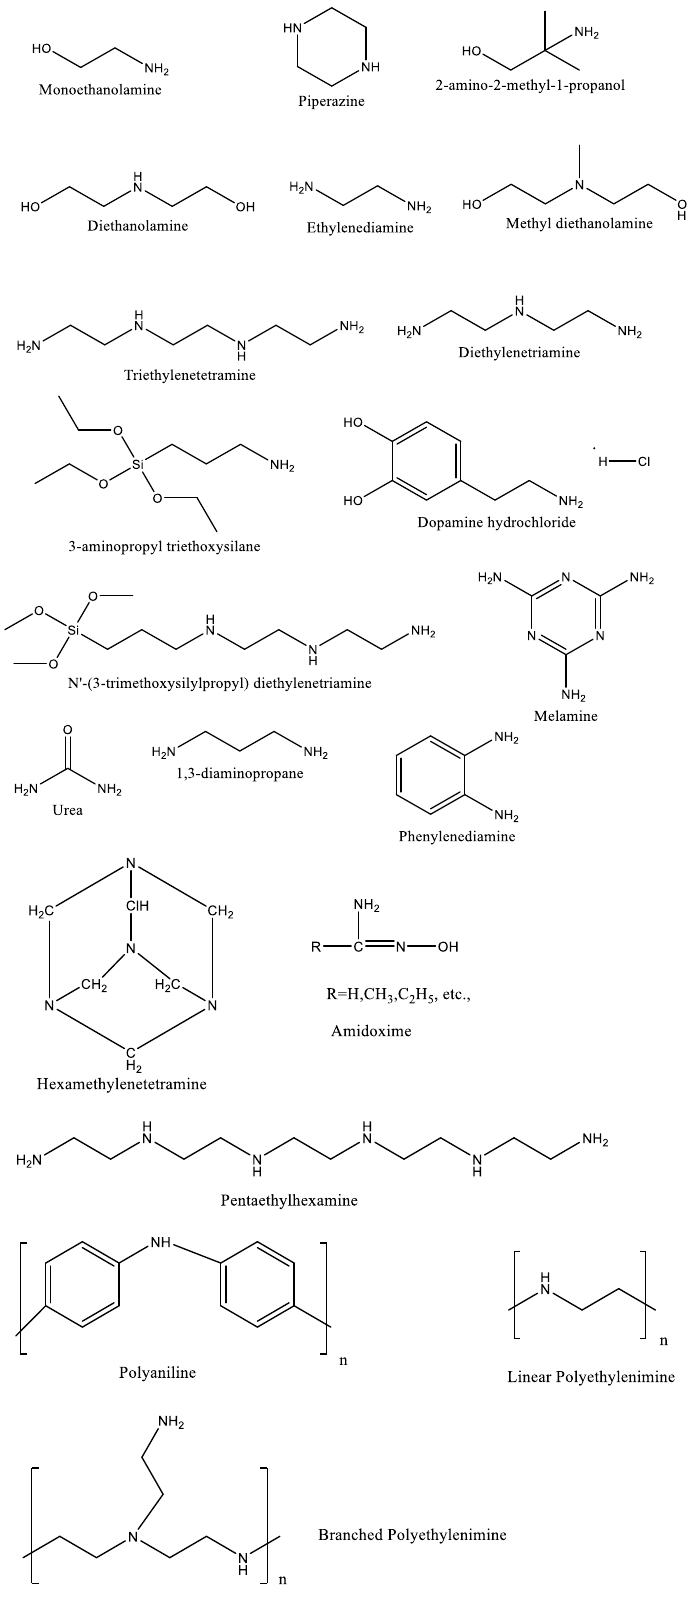
Figure 7. Chemical structures of the amine species used for functionalizing the porous carbon ma- terials.